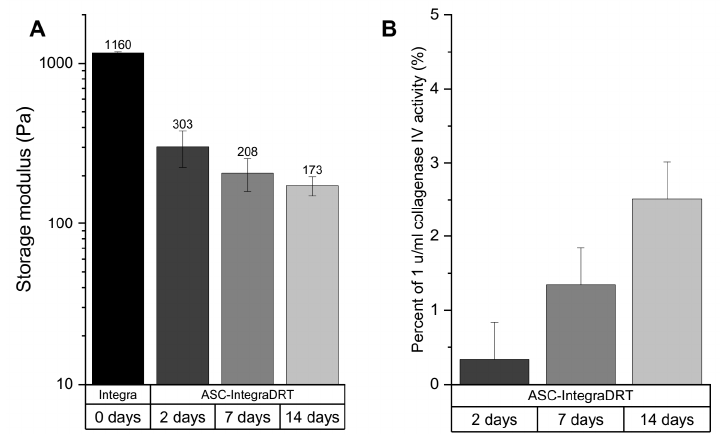
Figure 4. The elasticity of ASC–Integra ® DRT constructs on days 2, 7, and 14 after cell seeding expressed as storage modulus ( A ). Collagenolytic activity of the constructs ( B ). The decrease in ASC–Integra ® DRT elasticity was positively correlated with the increase in the proteolytic activity at the same time